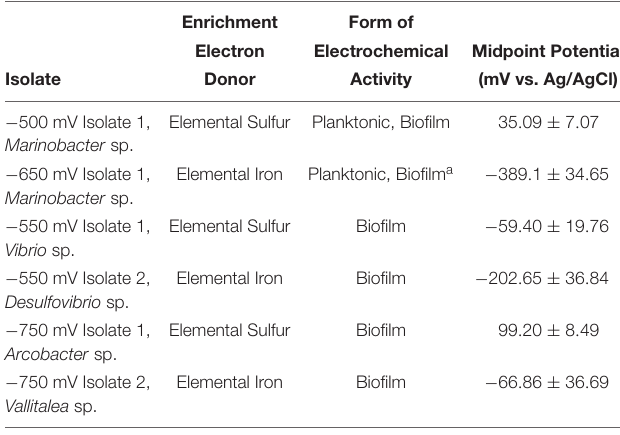
TABLE 3 | Calculated midpoint potentials of isolates determined by cyclic voltammetry tests in planktonic and biofilm associated